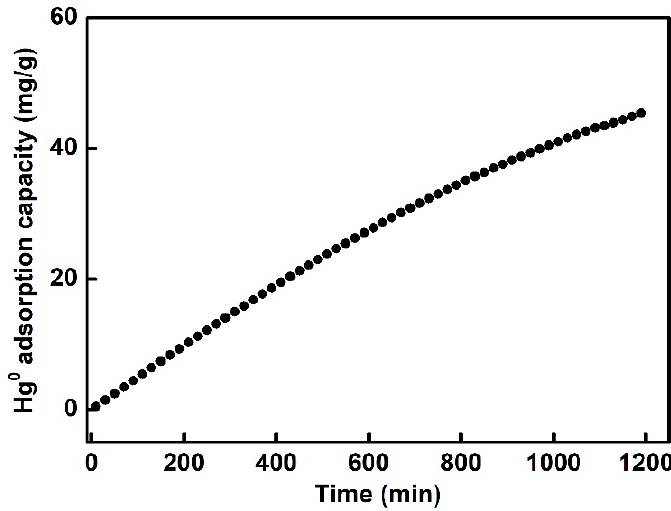
Figure 7. Hg 0 adsorption-capacity curve for S-AC as a function of time.